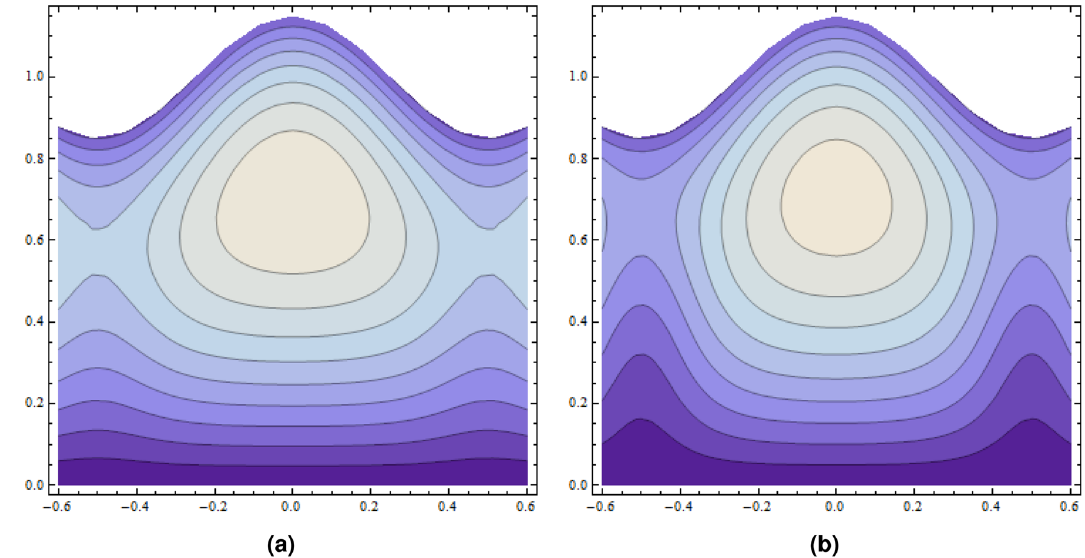
Figure 4. Plots of several stream lines with α = 0.2 , ε = 0.15 , F = 0.1 , δ = 0.05 , ( a ) ζ = 0.02 , ( b ) ζ = 0.03 .